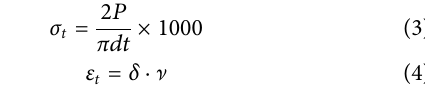
Frontiers in Earth Science |